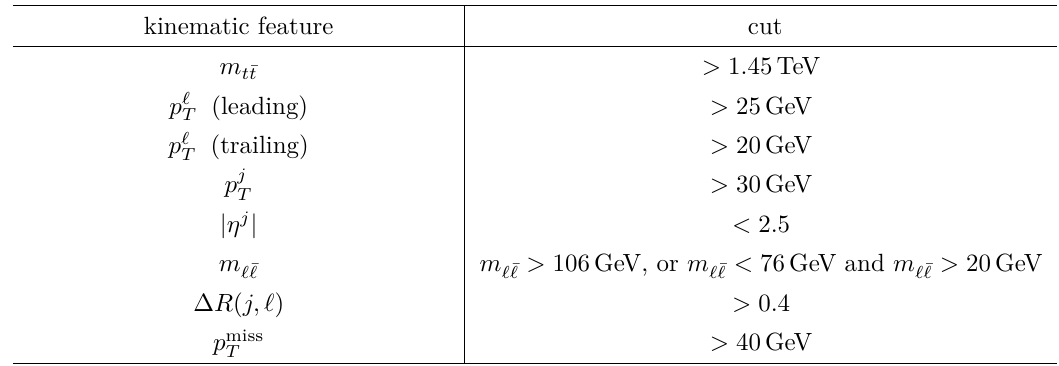
Table 3. Selection and acceptance cuts imposed on the final-state particles of the t ¯ t → b ¯ b‘ + ‘ − ν ‘ ¯ ν ‘